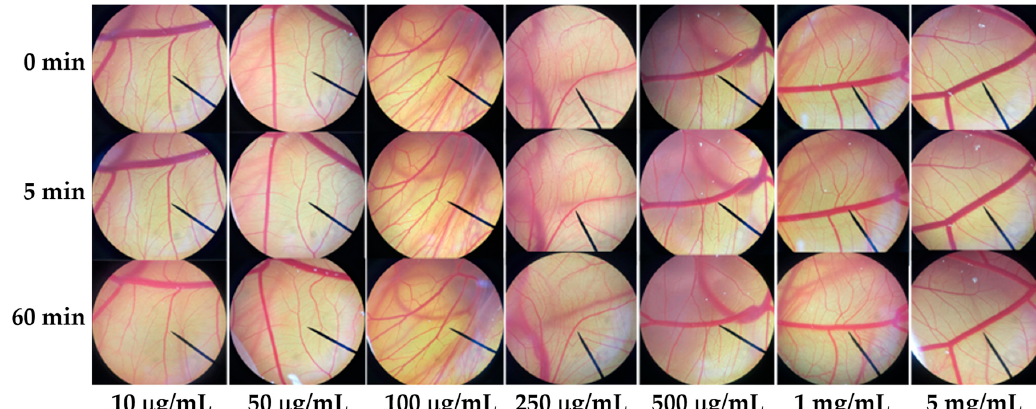
Figure 8. Photographs of the chorioallantoic membrane before and after exposure to the Sripanya pomegranate peel extract obtained by maceration in 60% v/v of ethanol (E60).